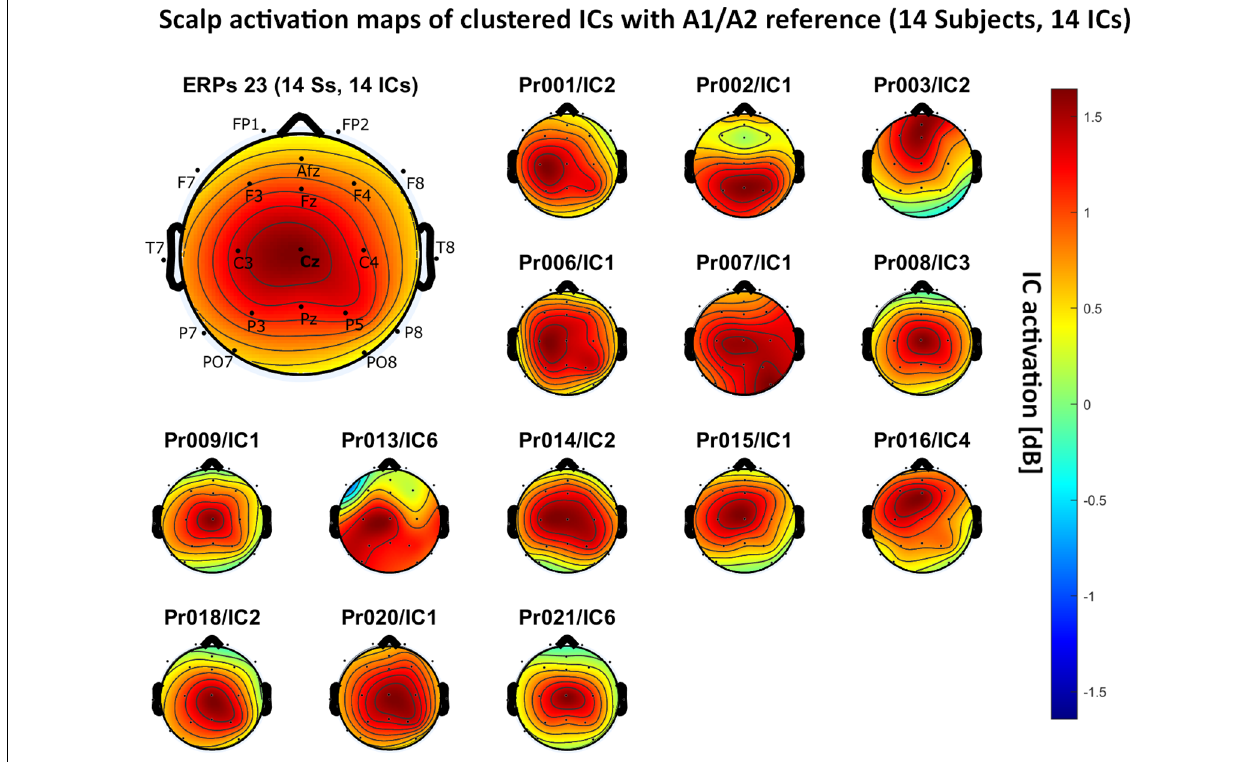
FIGURE 5 | Scalp activation for the selected independent components (ICs) for 14 subjects with A1/A2 as the reference site. The color-coding indicates the activation of the components in dB. The average activation is plotted in the top-left corner, including detailed electrode locations.